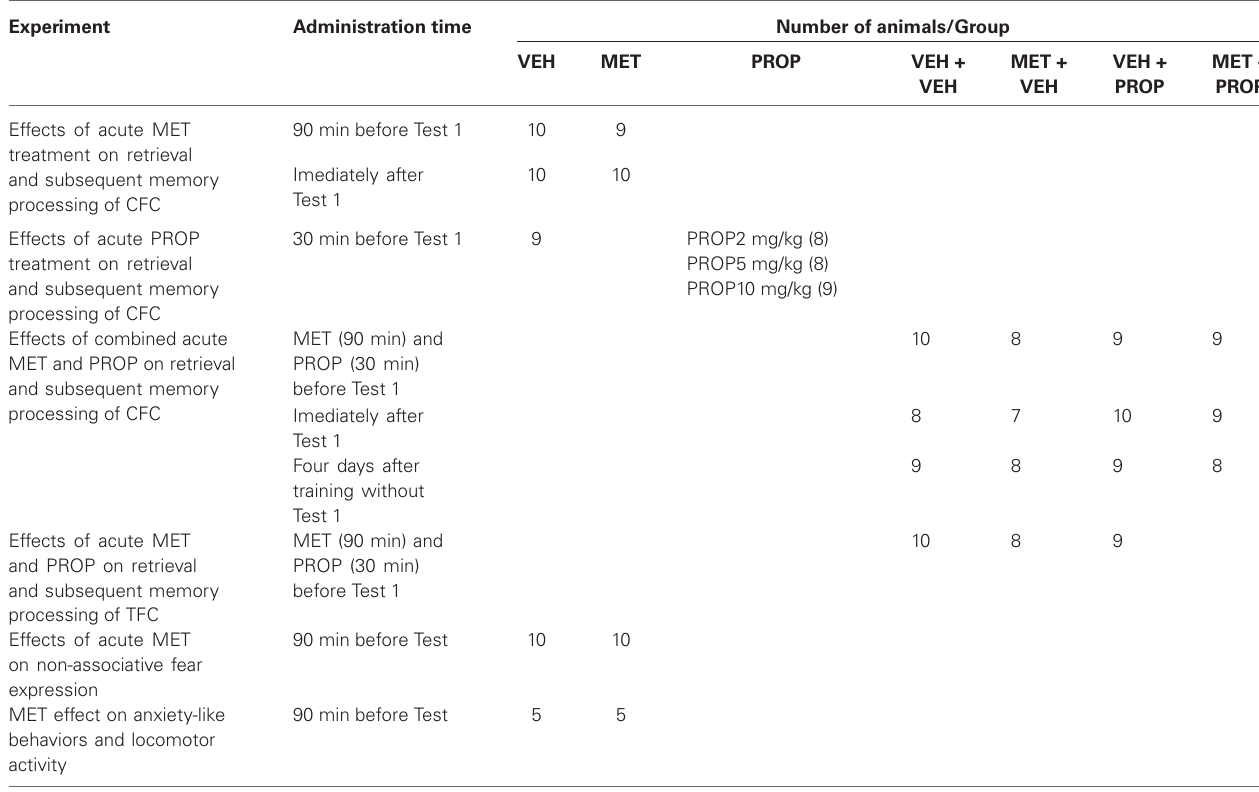
Table 1 | Treatment design used in the behavioral experiments . Experiment Administration time Number of animals/Group VEH MET PROP VEH + MET + VEH + MET + VEH VEH PROP